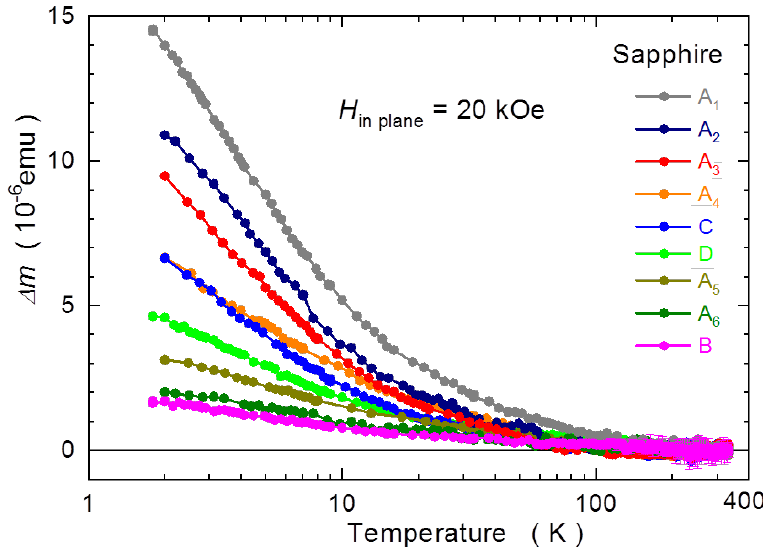
Figure 1. Temperature variation of the magnetic moment m in various sapphire samples originating from four different vendors, A to D, as indicated in the legend. The results for all the samples are rescaled to correspond to a 30 mg sample and the temperature induced changes ∆ m are calculated with respect to m (300 K). Magnetic field H of 20 kOe is applied in the plane of the samples, i.e., H is perpendicular to the c axis of these c -plane sapphire specimens. For clarity, the error bars are indicated only for sample B.